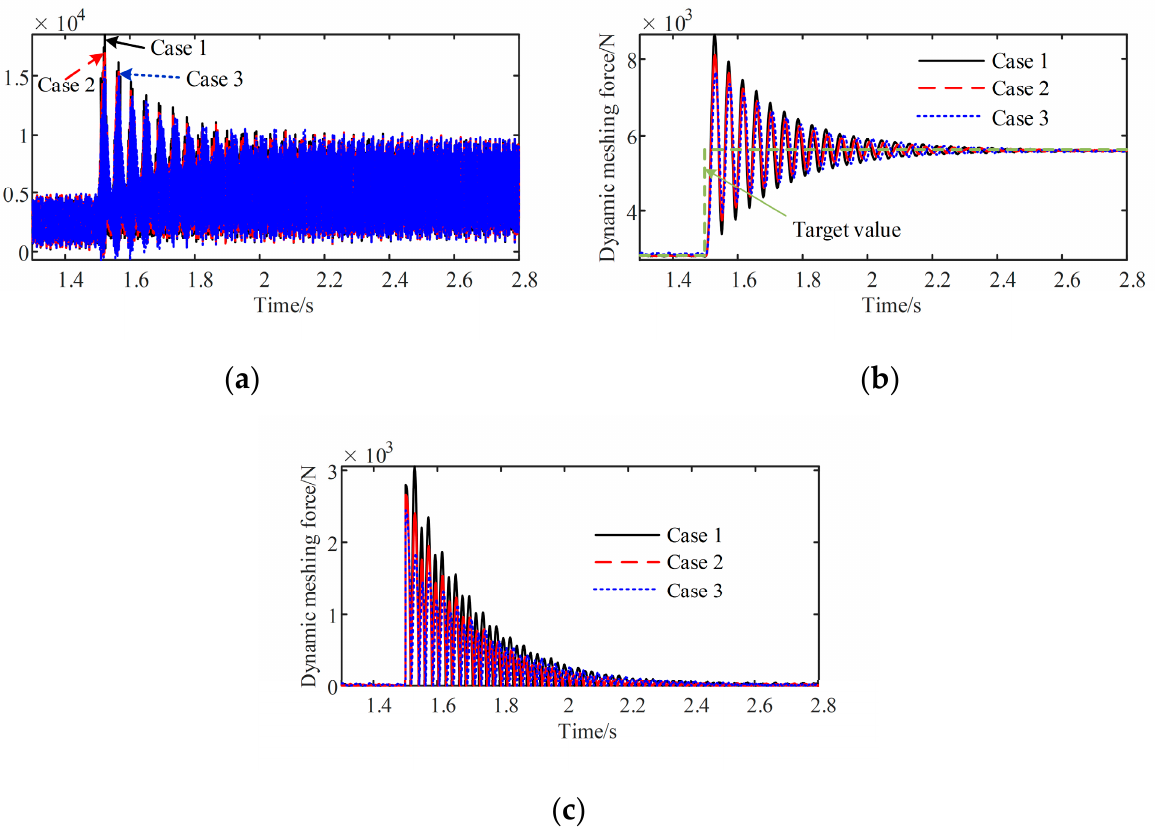
Figure 26. The meshing force of the first gear pair: ( a ) meshing force of the first gear pair at time- varying meshing stiffness; ( b ) root mean square value of the meshing force of the first gear pair; ( c ) meshing force decay process.